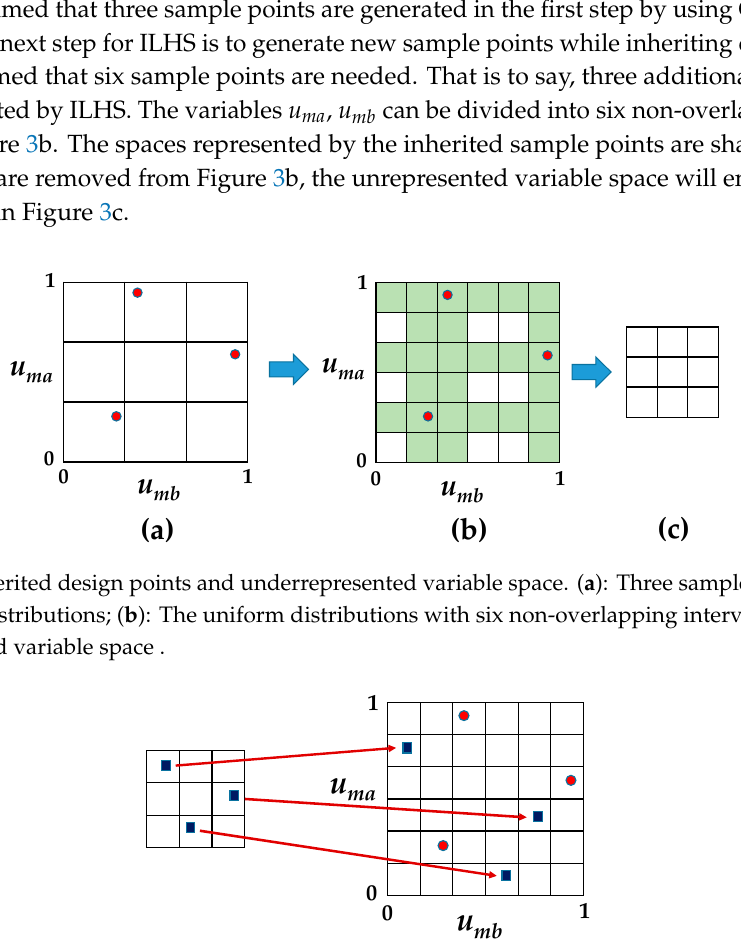
Figure 2. The schematic diagram of inherited Latin hypercube sampling (ILHS).